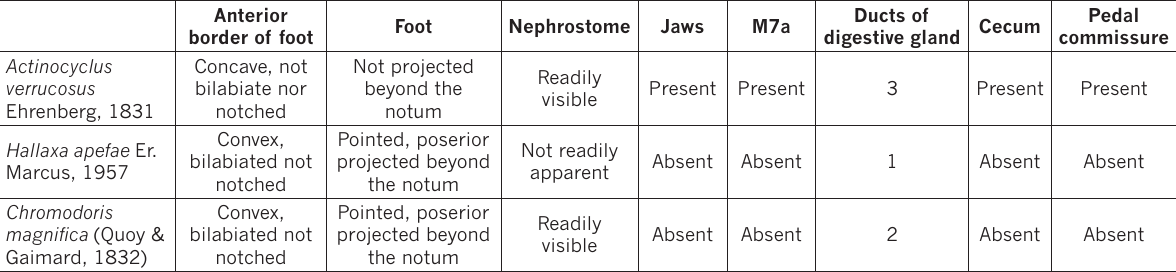
Table 1. Comparative table of some features between Actinocyclus verrucosus , Hallaxa apefae and Chromodoris magnifica (all these features of the three species was analyzed in Lima